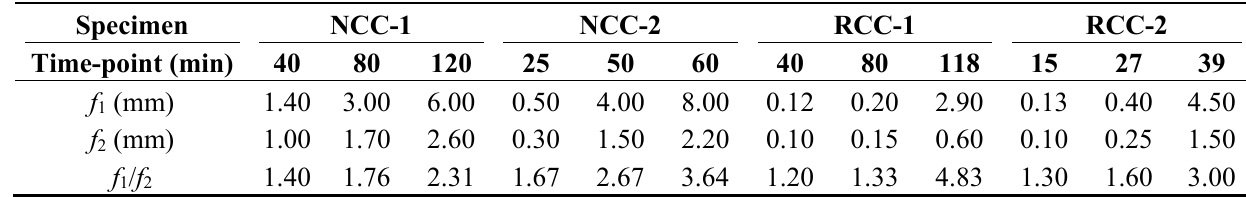
Table 6. Lateral deflection and their ratios of specimens at different